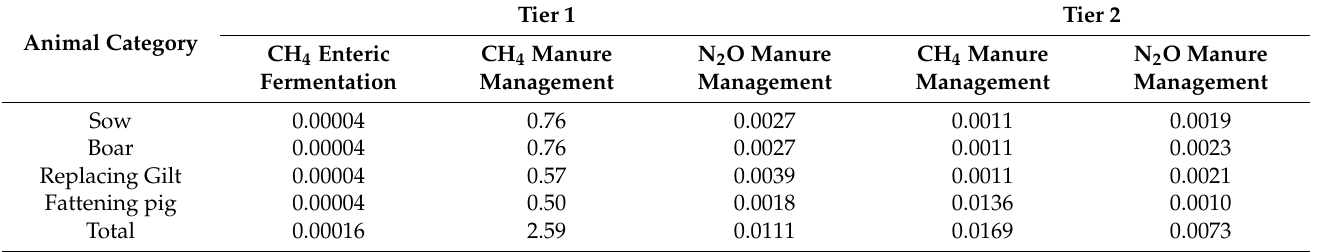
Table 11. Estimated CH 4 emissions derived from enteric fermentation and manure management and N 2 O emissions from manure management using Tier 1 and 2 methodologies per animal within each animal category for the average pig farm in 2019 (Gg CO 2 -eq).